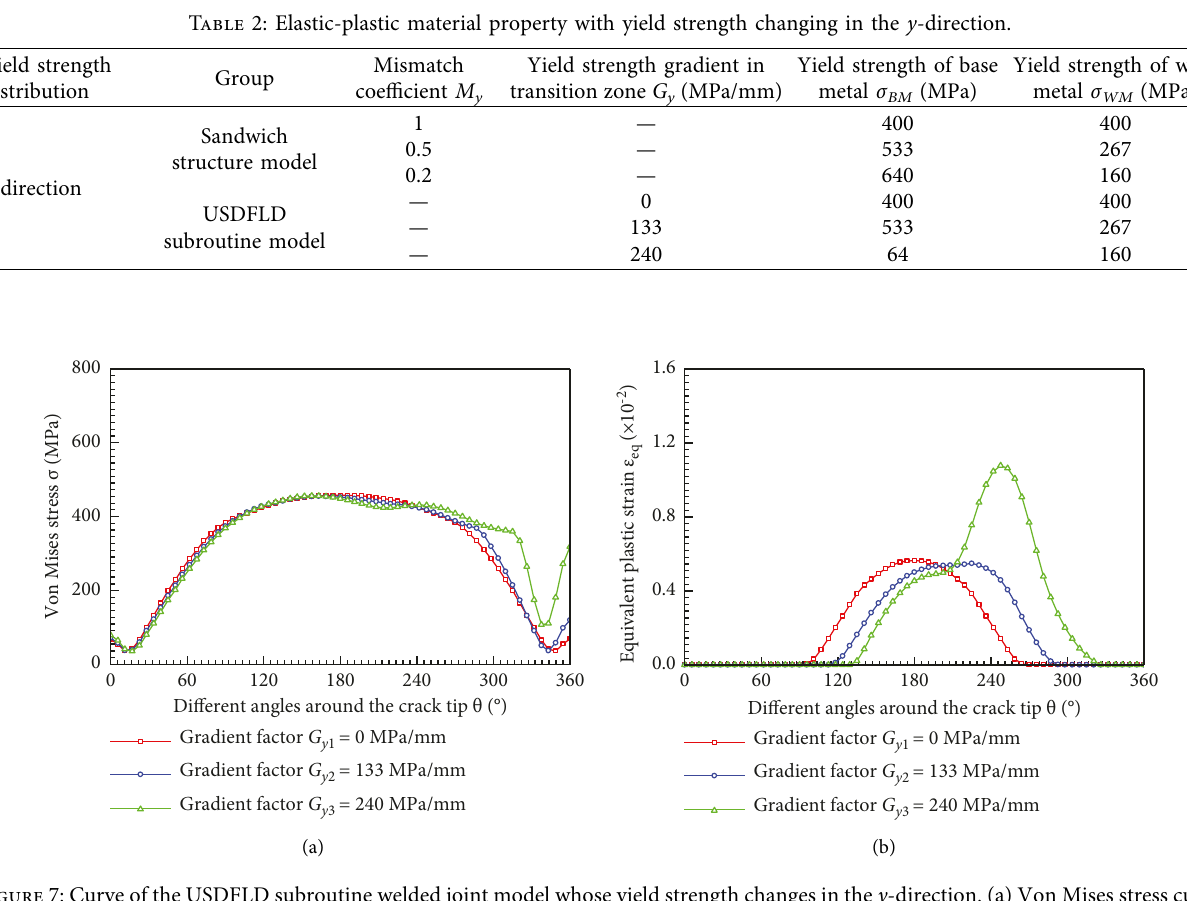
Figure 7: Curve of the USDFLD subroutine welded joint model whose yield strength changes in the y -direction. (a) Von Mises stress curve at crack tip. (b) Equivalent plastic strain curve at crack